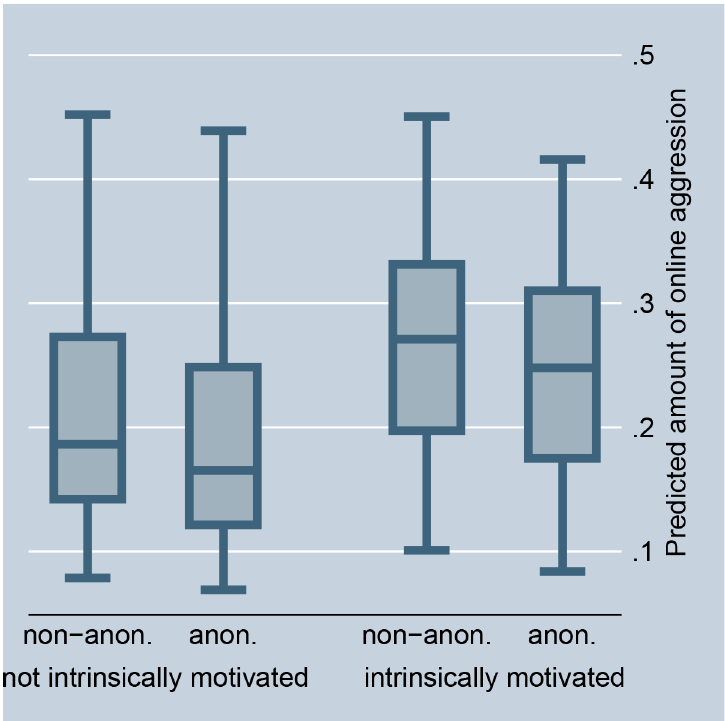
Fig 4. Online aggression dependent on intrinsic motivation and anonymity (random-effects). Predictions of Table 1, Model